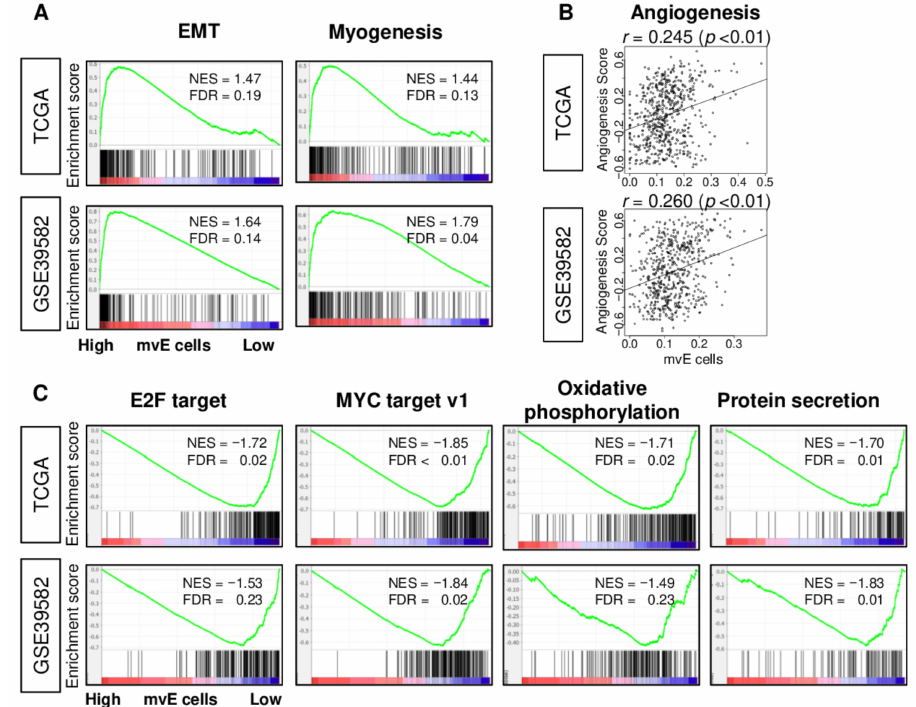
Figure 3. Gene set enrichment analysis (GSEA) of mvE cell CRC in the TCGA and GSE39582 cohorts. ( A ) Enrichment plots of gene sets enriched in high mvE cell CRC and ( B ) correlation plots between mvE cell score and angiogenesis score. ( C ) Enrichment plots of gene sets enriched in low mvE cell CRC. The top one-fourth was used as a cut-off to divide low and high groups for each cohort in ( A ) and ( C ). Significantly enriched gene sets were selected based on false discovery rate (FDR) q -value < 0.25. Spearman’s rank correlation test was used to analyze in ( B ). EMT; epithelial–mesenchymal transition, NES; normalized enrichment